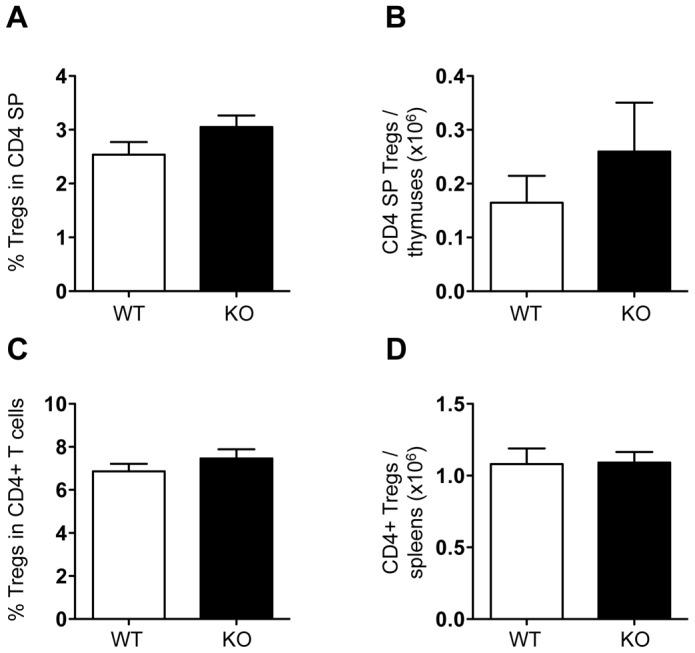
Regulatory CD4+ T cell development is normal in KSR1-deficient T cells.Thymocytes (A, B) and splenocytes (C, D) of WT (white bars) and KSR1-/- (black bars) mice were analyzed for the presence of regulatory CD4+ T cells by flow cytometry. A, C: Percentage of FoxP3+ CD25+ cells in CD4+ CD8- single positive (SP) thymocytes (A) and CD4+ CD3+ T cells (B). B, D: Numbers of FoxP3+ CD25+ CD4 SP by thymuses (B) and CD4+ T cells by spleens (D). Data is presented as mean + SEM and represent 10-12 mice per group. There were no significant differences between WT and KO mice (t-test).